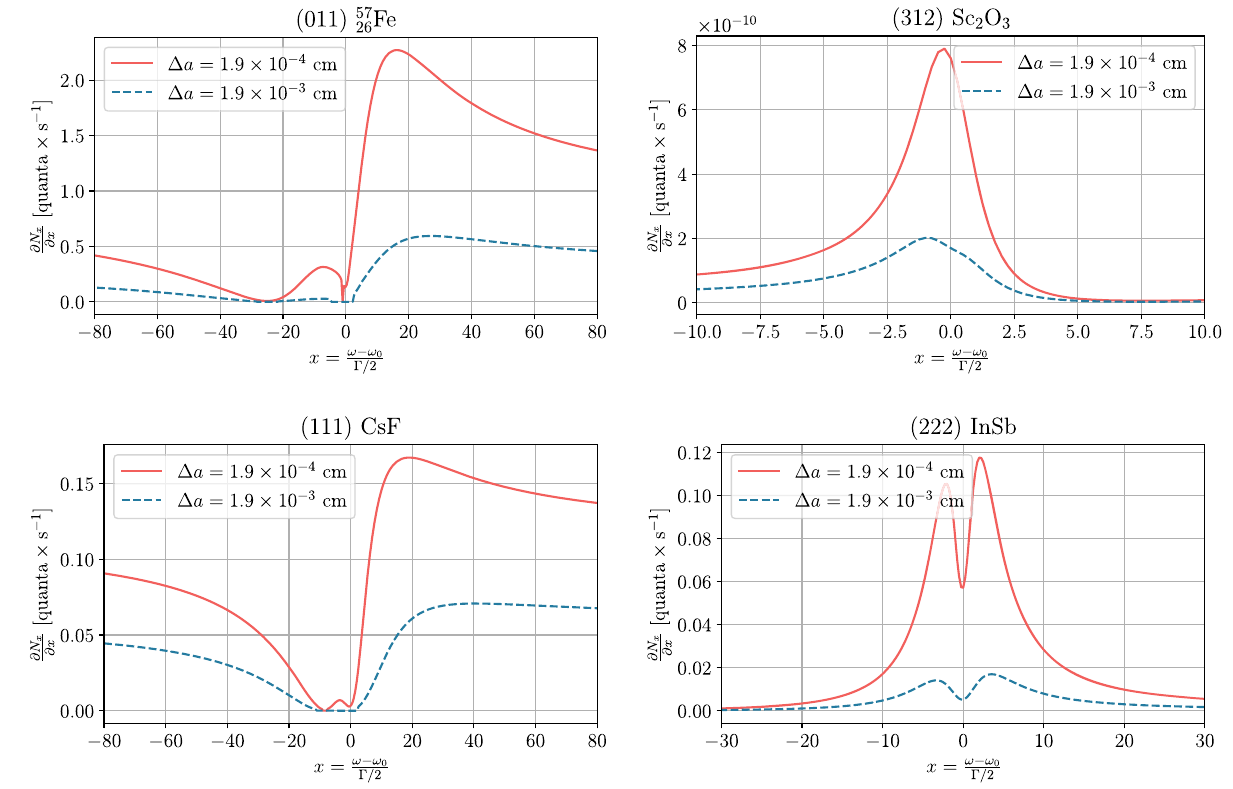
FIG. 2. The number of emitted x-ray photons per second as a function of the dimensionless frequency x ¼ ð ω − ω 0 Þ = ð Γ = 2 Þ . The results are averaged over the electron beam parameter distributions, for different transversal widths and divergences of the electron beam, keeping the emittance constant. The figure compares the emission from the (011) reflex of α iron (top left), the (312) reflex of Sc 2 O 3 (top right), and the (111) reflex of CsF (bottom left). The bottom right panel shows pure PMR emission from the (222) reflection of the InSb crystal. For all panels, we assume an angular spread in the y direction of 10 − 3 rad. The crystal lengths are chosen as L ¼ 0 . 5 cm. Electron parameters are chosen according to the MAMI facility, with energy E ¼ 1000 MeV, vertical emittance ϵ ¼ 1 . 9 × 10 − 7 cm rad, and electron current is j ¼ 100 μ